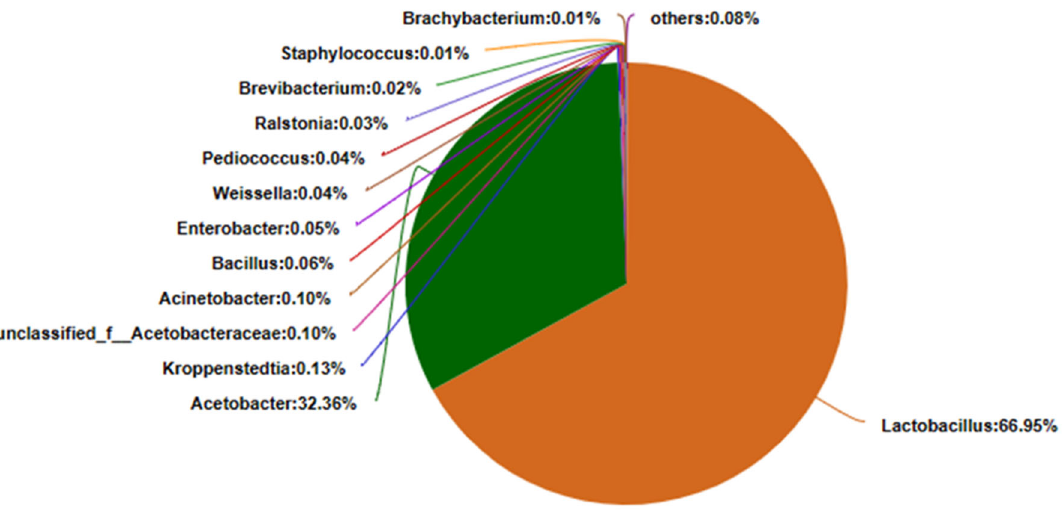
Figure 2. Bacterial community composition of fermented grain samples at genus level. Note: Rela ‐ tive abundances given in the figure were based on the mean of three replicates.